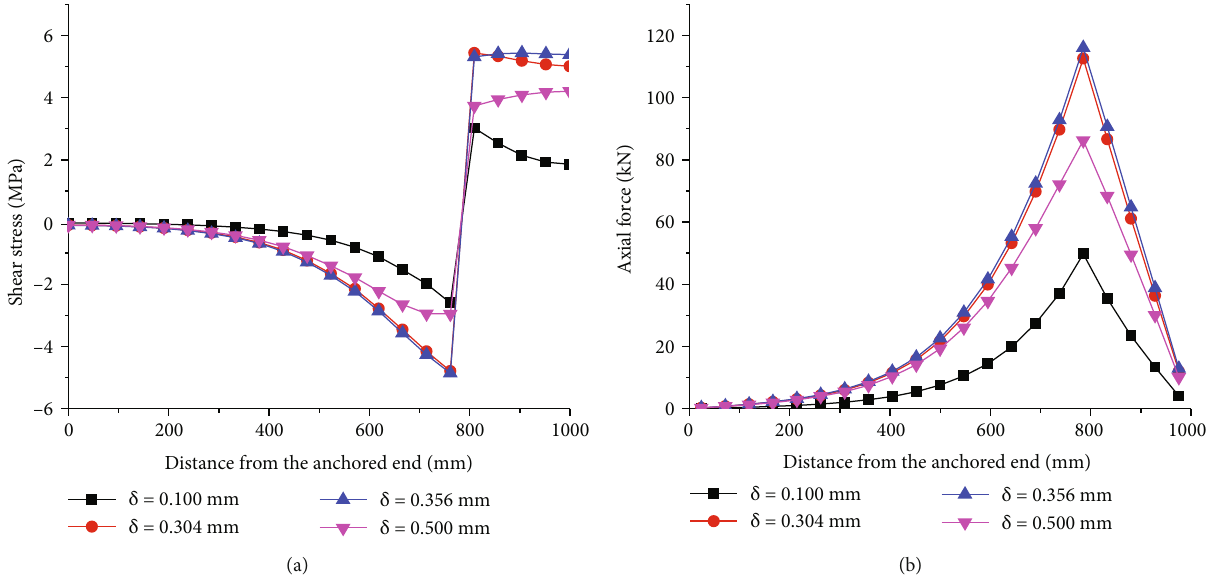
Figure 9: (a) Axial force and (b) interfacial shear stress distribution curves when x